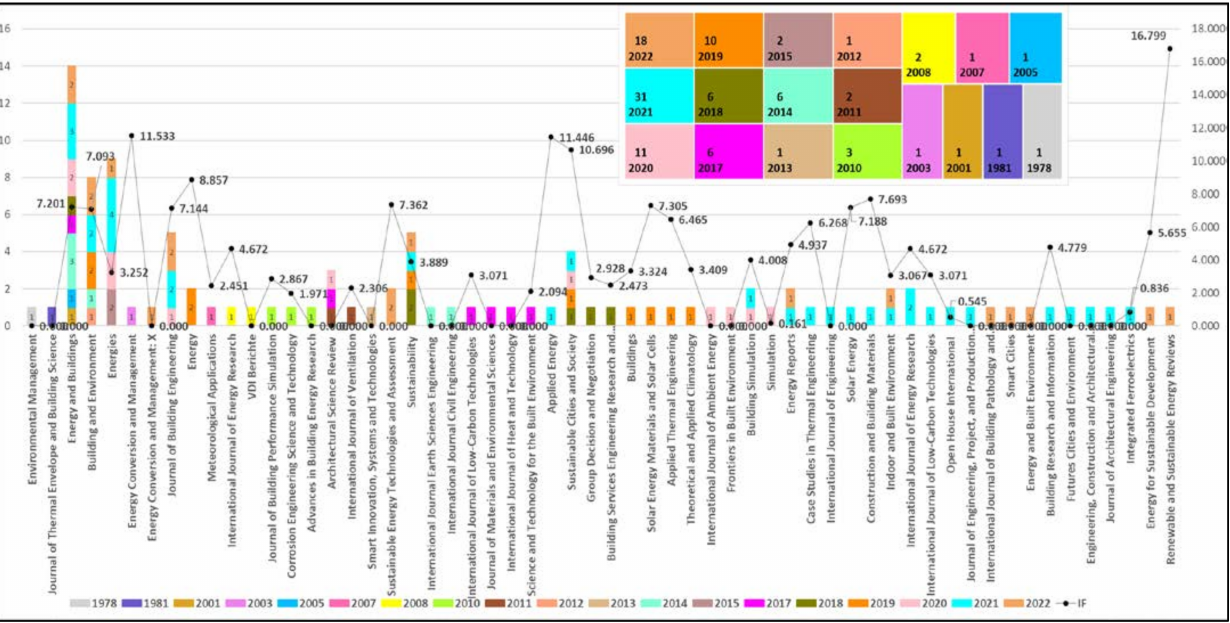
Figure 4. Co-occurrence